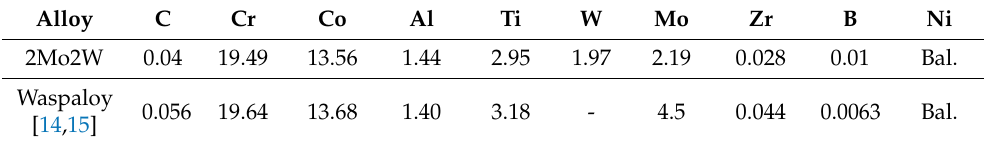
Table 1. Mass percentage compositions of alloys (wt%).